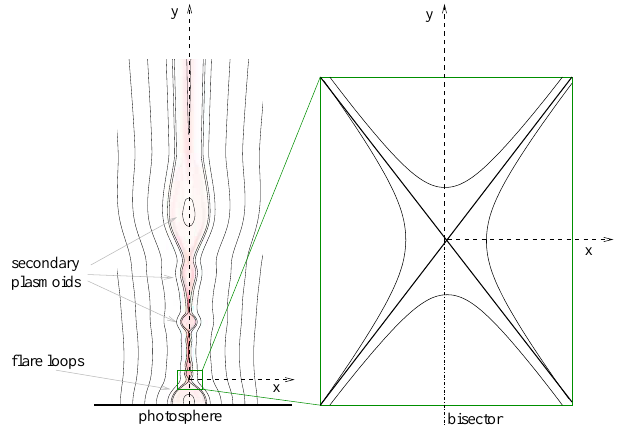
Fig. 1. Scenario of a flare loop with an